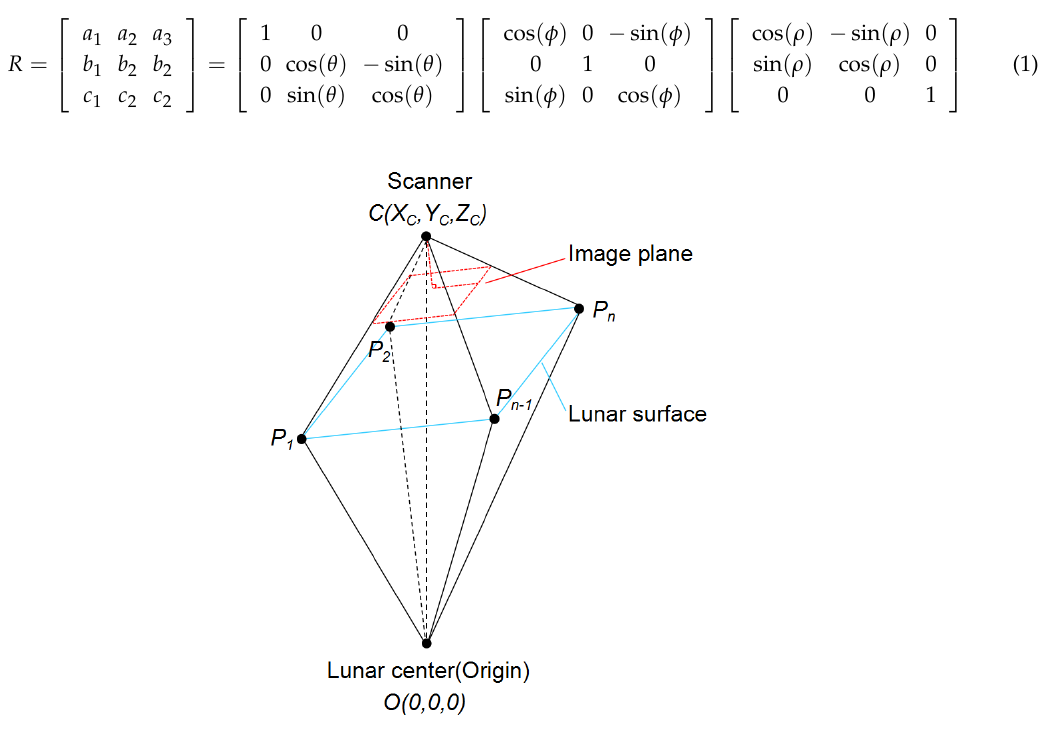
Figure 4. The coordinate